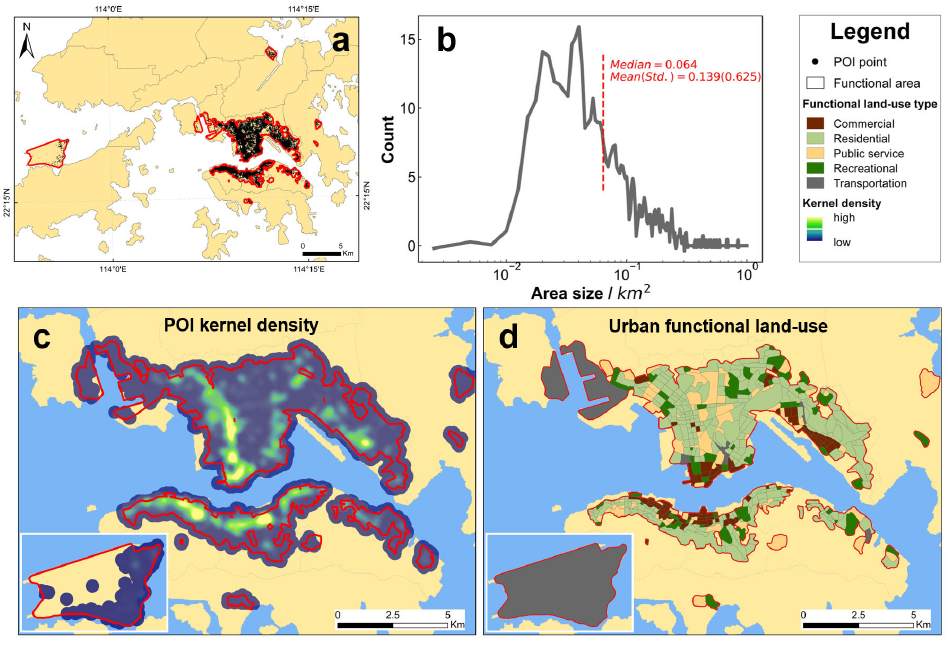
Figure 2. ( a ) Geographical setting of the study region, Hong Kong, China. The research is carried out within the red lines; ( b ) histogram statistics of the size for the functional area; ( c ) kernel density distribution of Point of Interest (POI) points; and ( d ) the functional land use distribution derived from the dataset of Land Utilization in Hong Kong (LUHK), including five categories: commercial, residential, public service, recreational and transportation.